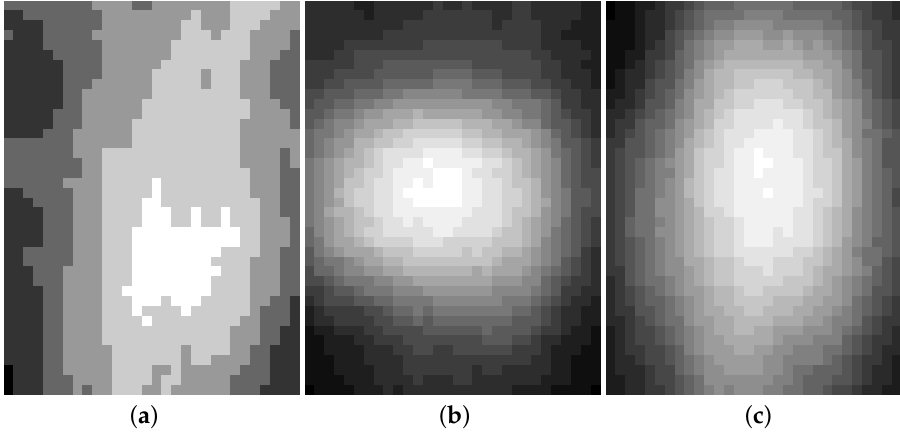
Figure 10. Example Data for Pose Detection: ( a ) Empty; ( b ) Sitting; ( c ) Laying.